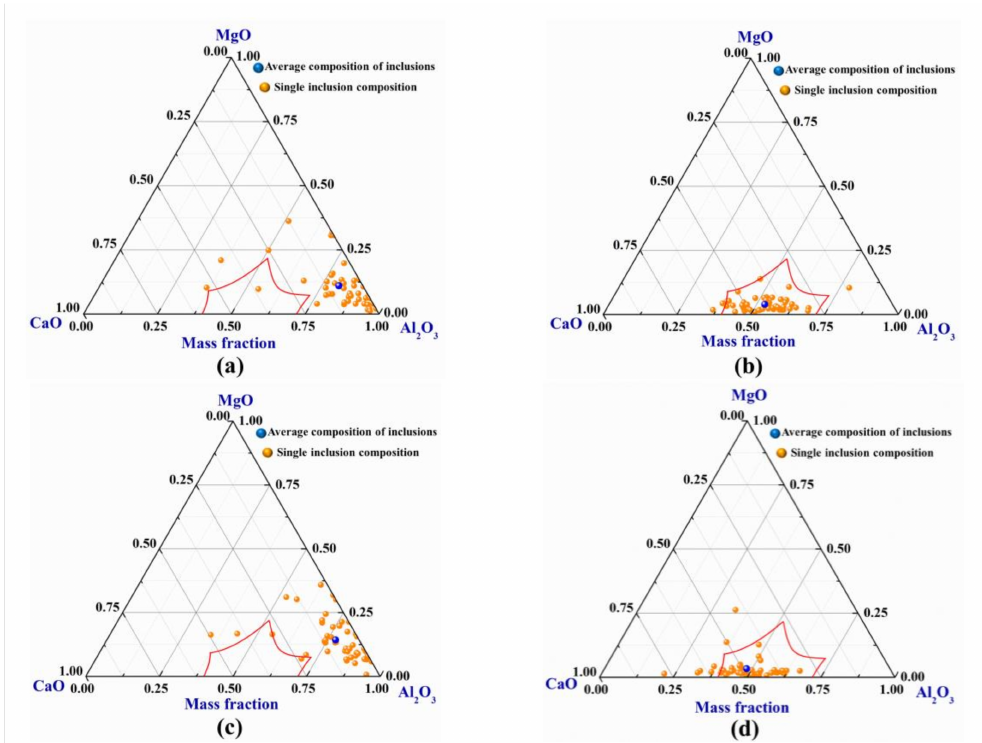
Figure 6. The change of inclusion composition in steel before and after calcium treatment: ( a , b ) are the changes of inclusions in steel A before and after calcium treatment; and( c , d ) are the changes of inclusions in steel B before and after calcium